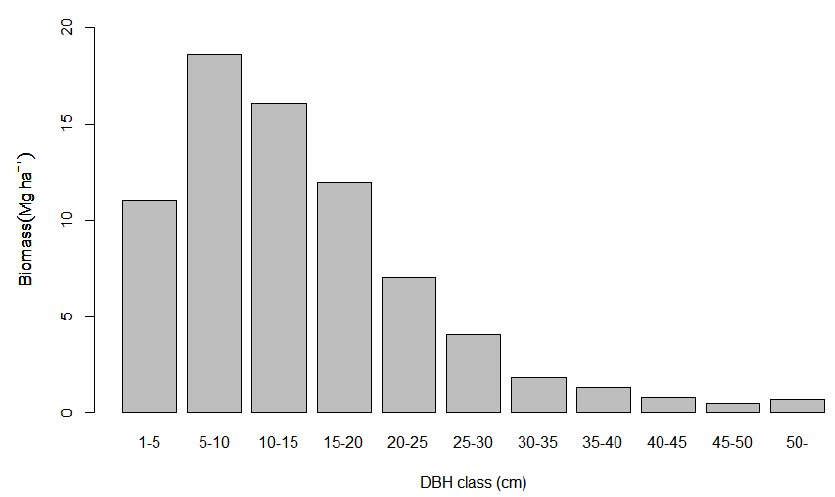
Figure 2. Distribution of forest biomass among diameter classes in the Mulun plot.